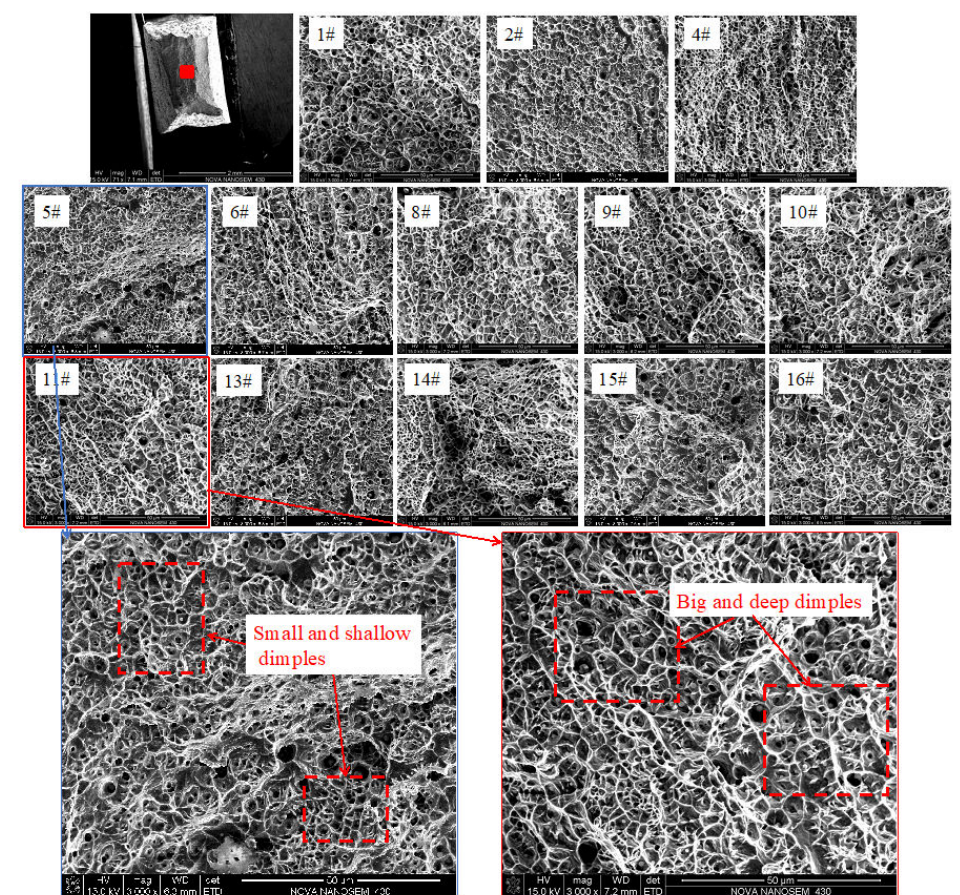
Figure 7. SEM images of fracture surface (SEM represents scanning electron microscope).